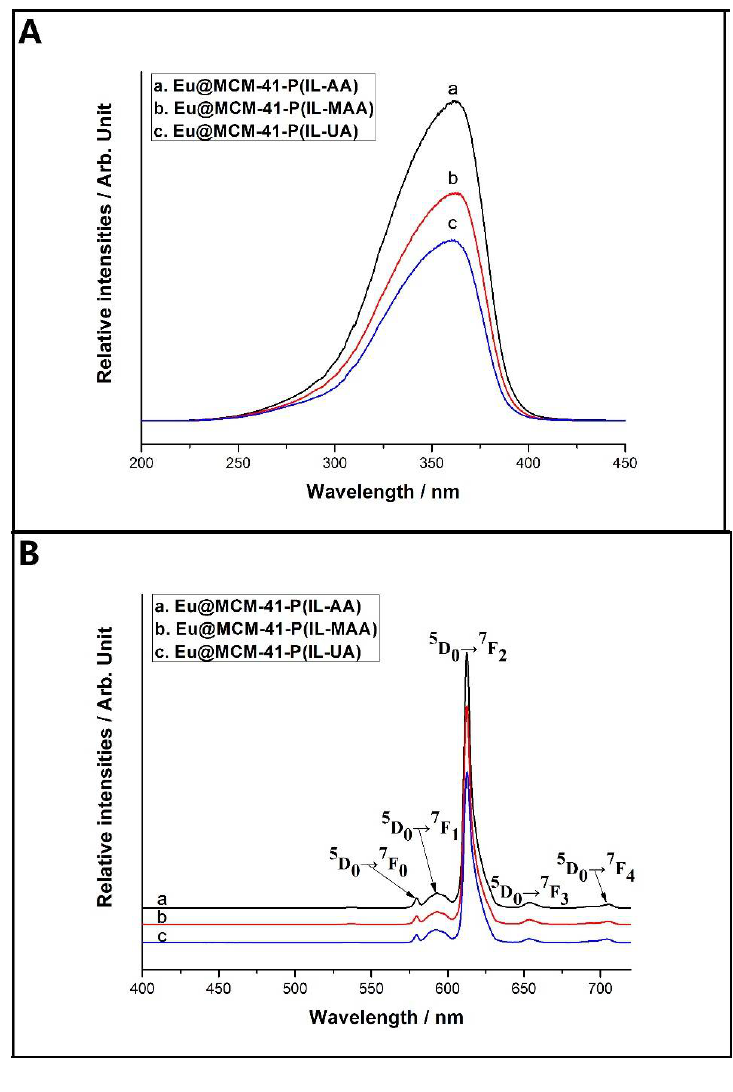
Figure 4. Excitation (( A ) monitored at λ = 612 nm) and emission (( B ) excited with λ = 360 nm) spectra of the hybrid materials.